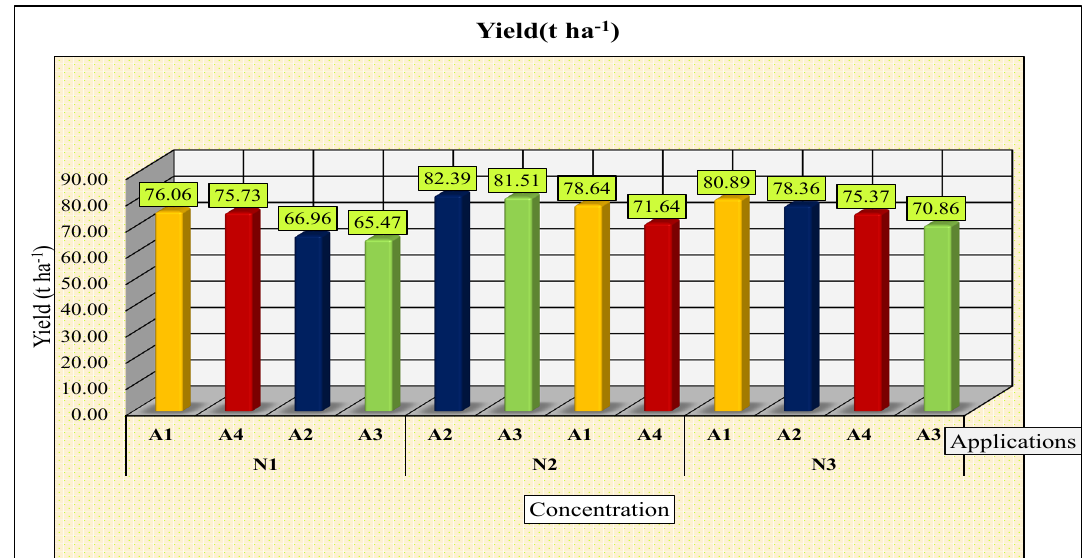
Figure 2. Main effects of treatments under study on yield (t ha -1 ), Irrigation of Santa Rita–Arequipa, 2016